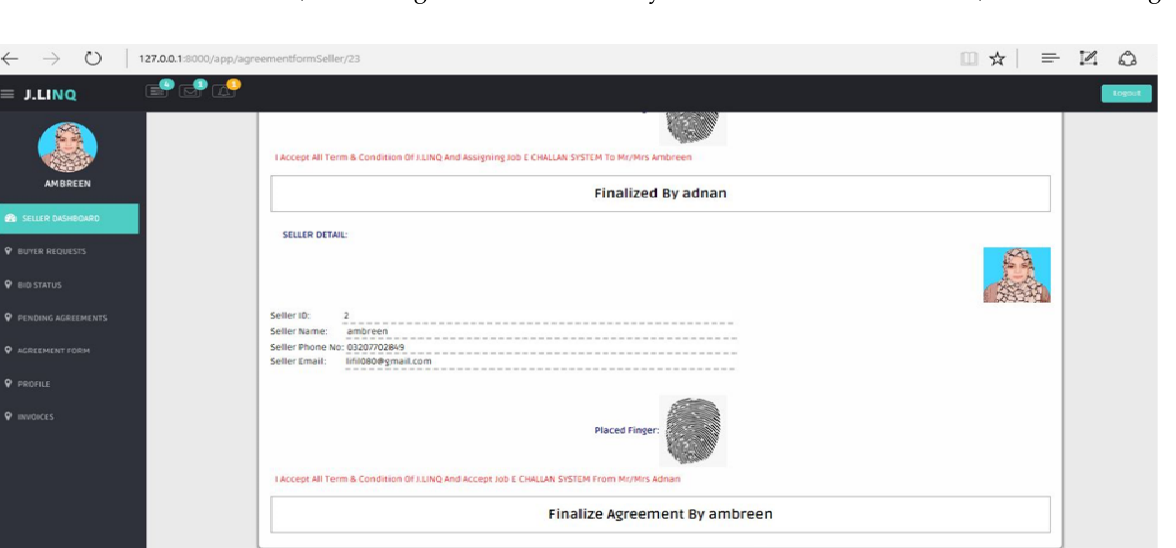
Figure 18. Finalization of the agreement with the biometric signature from the seller’s side.